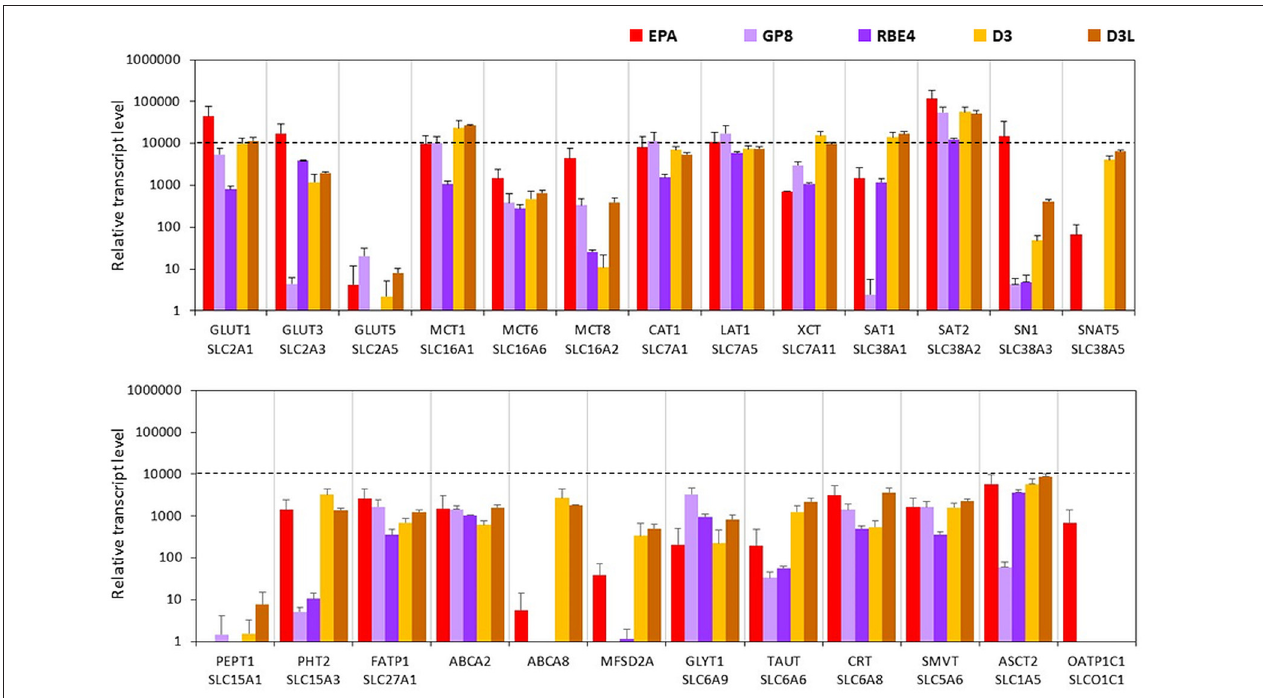
( Figure 1 ) epithelial cells stained intensely for claudin-4 ( Figure 9 ), a TJ protein typical for epithelial cells.